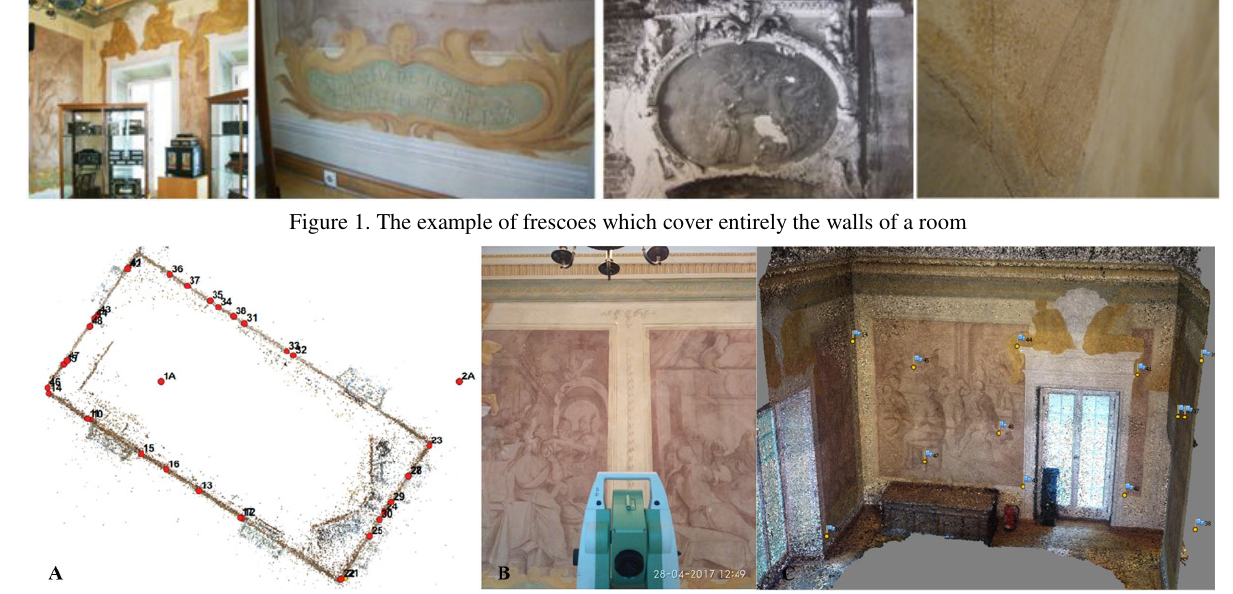
Figure 2. The distribution of control and check points used in images